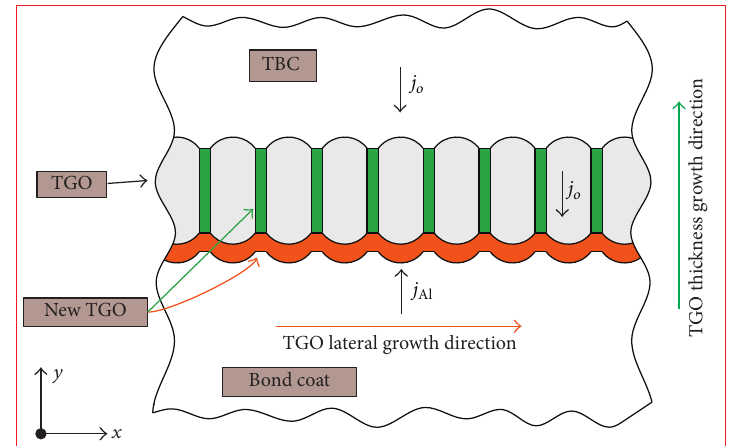
Figure 2: A schematic of TGO growth phenomena.